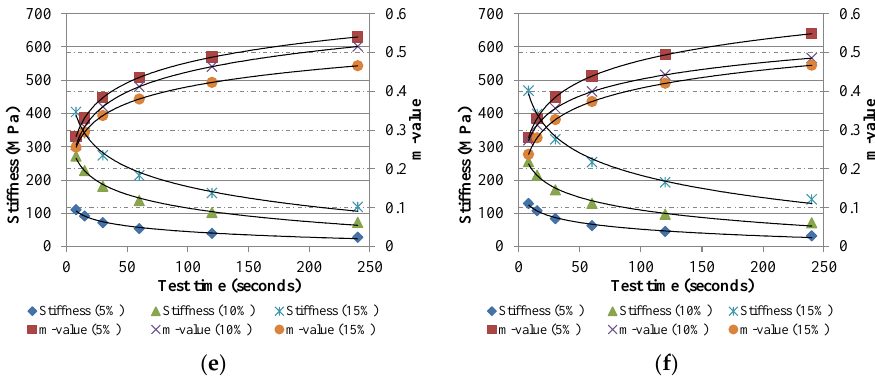
Figure 4. Stiffness values and m-values of RAP sources A–F modified with reclaimed asphalt pavement (RTFO) binder PG 58-28 at −6 °C, ( a – f ) RAP sources A–F.